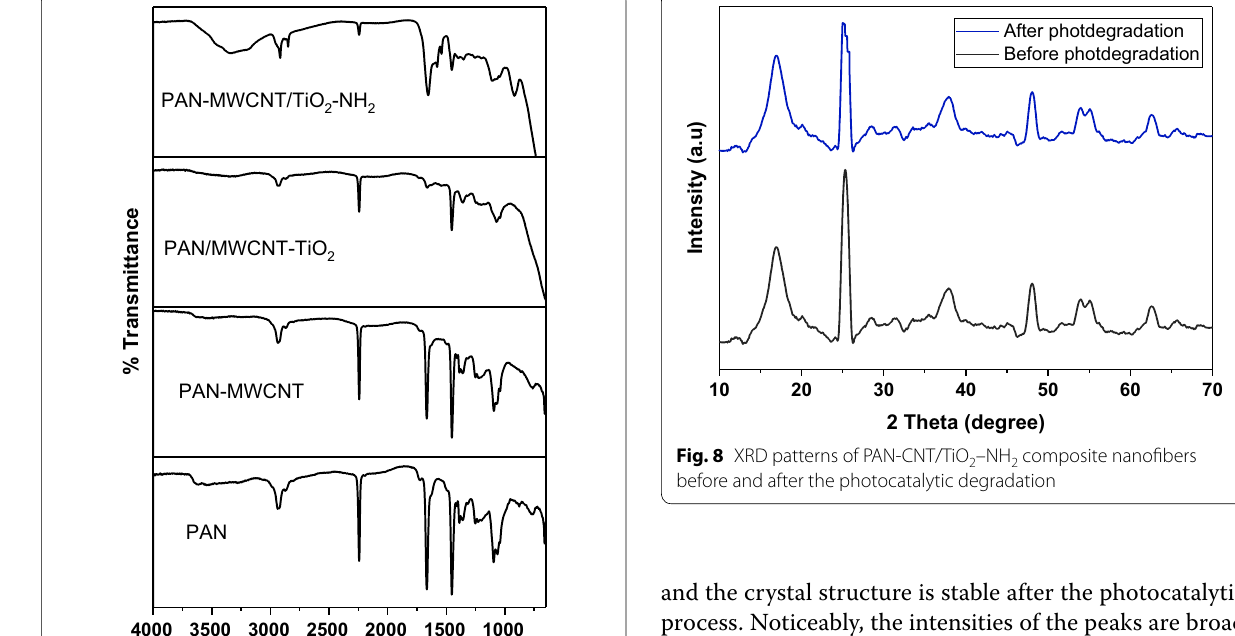
and the crystal structure is stable after the photocatalytic process. Noticeably, the intensities of the peaks are broad and weak, which indicate that the crystallinity is poor and the crystallite size is small. Fig. 7 FTIR spectra of PAN, PAN-MWCNT, PAN/MWCNT-TiO 2 , and